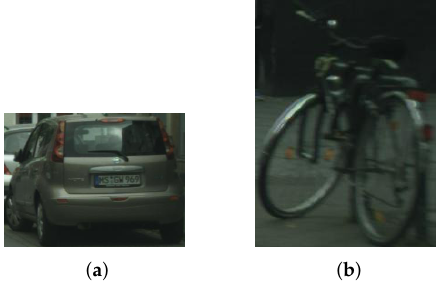
Figure 5. Γ CSD dataset. ( a ) Car; ( b ) Bicycle. Table 3. Sample sizes of each category per subset in the Γ CSD